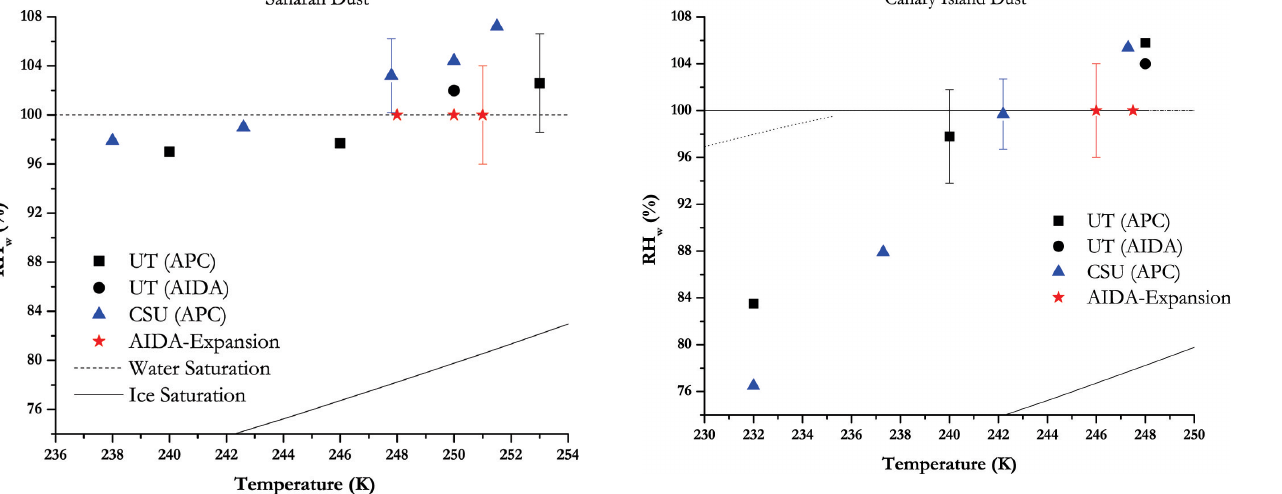
Fig. 4. Comparison of onset RH w for 0.1% activated ice fraction as a function of temperature for Saharan Dust aerosols between UT, CSU and AIDA experiments. UT-CFDC data based on 5µm chan- nel. UT-CFDC data at RH w > 100% and T > 250K could represent ice and/or water activation. Error bars represent uncertainty in RH measurements (see text for details). Dashed and solid lines: water and ice saturation respectively (Murphy and Koop, 2005).